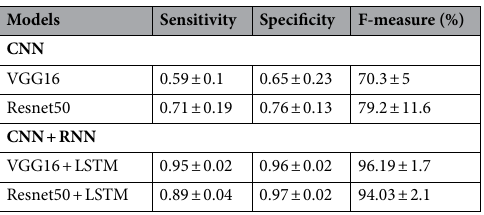
Table 2. Performance of the various models on the total dataset.